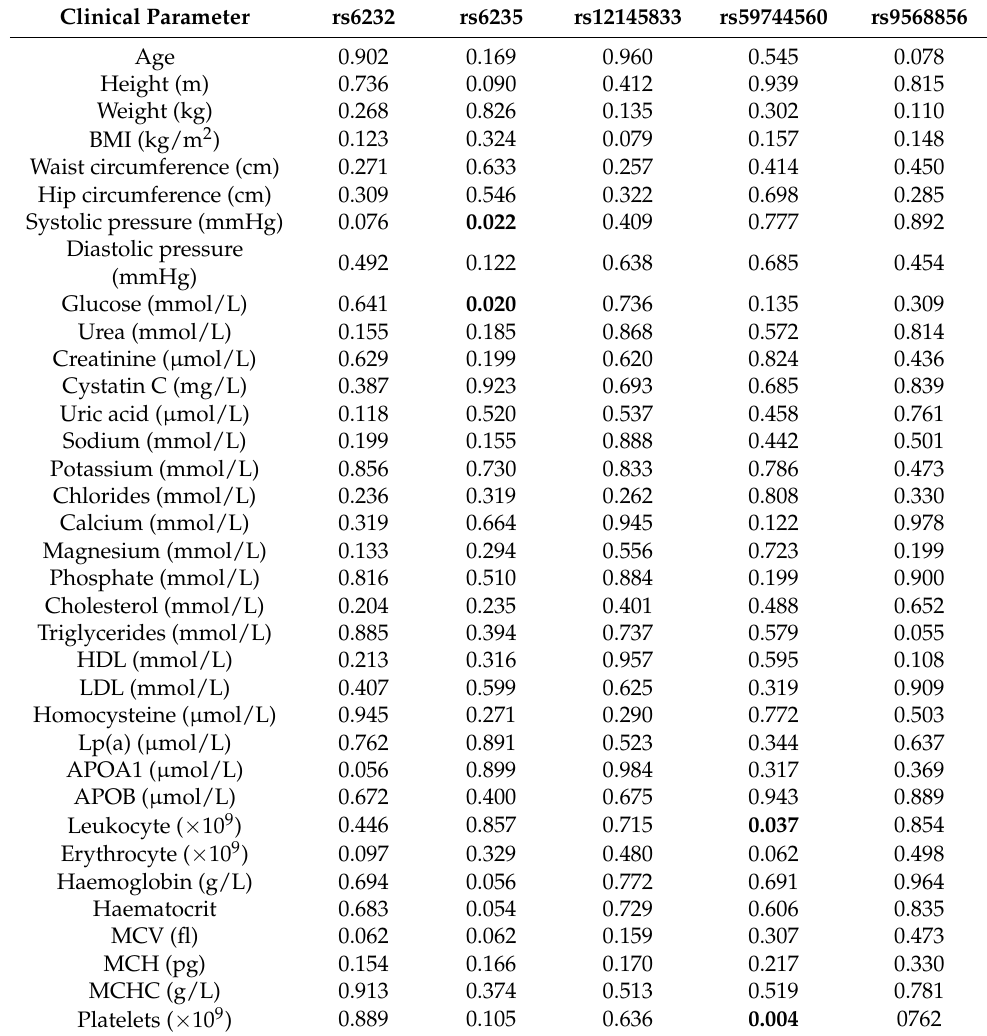
Table 4. p -values for clinical data comparison between groups with different alleles